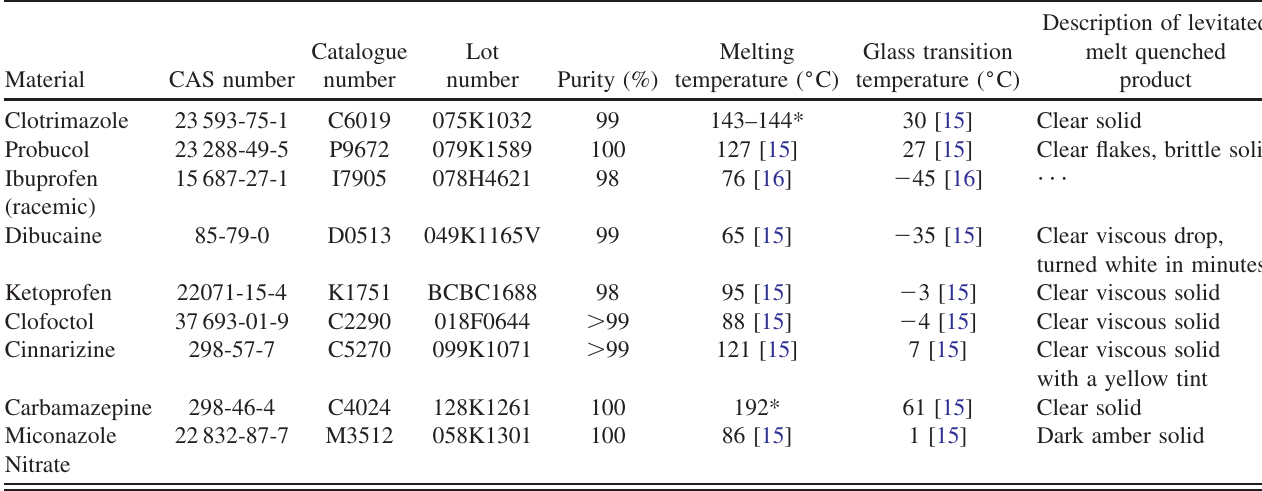
TABLE I. Details of the starting materials that were purchased from Sigma-Aldrich. Also shown are some physical properties taken from Sigma-Aldrich (*), Baird et al. [15], and Dudognon et al. for racemic Ibuprofen